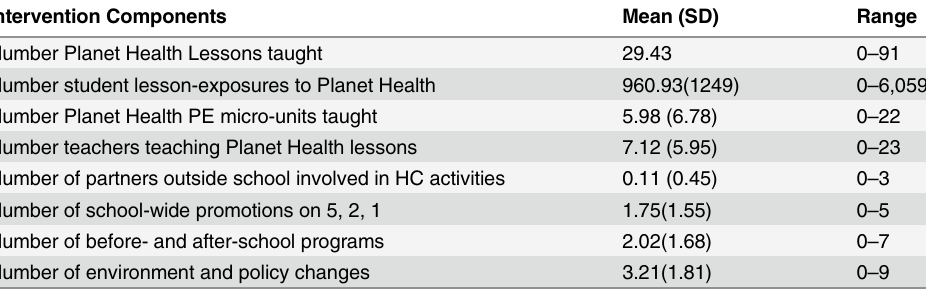
Table 3. Distribution of Intervention Components implemented in Year 2 in Massachusetts Middle Schools Participating in the Healthy Choices Program (N = 35).